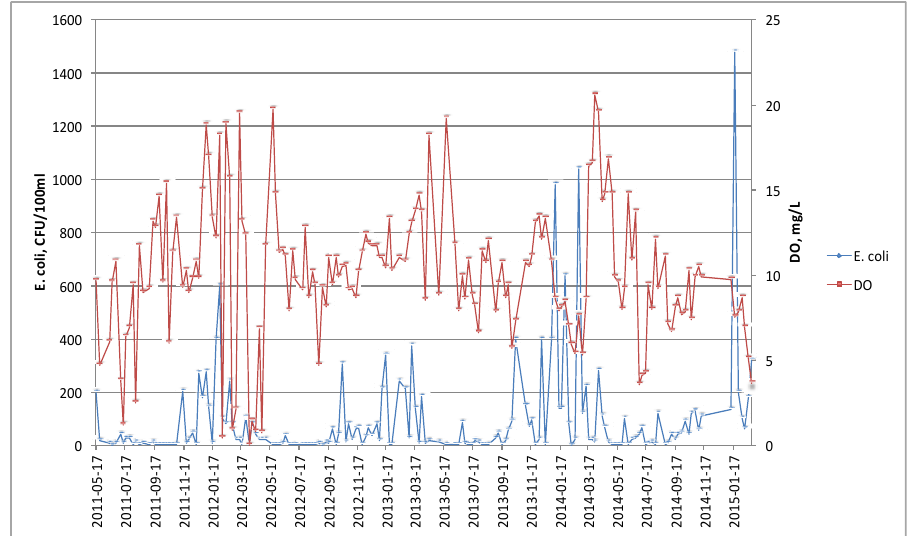
Figure 7. The relationship between E. coli population and DO concentration in the effluent of Pond 1. Figure 9 indicates the average, median, minimum and maximum values of E. coli concentration for the four different seasons. The statistical analysis indicated that E. coli concentrations were well correlated with temperature ( ρ = − 0.50), where the negative correlation suggested that at lower